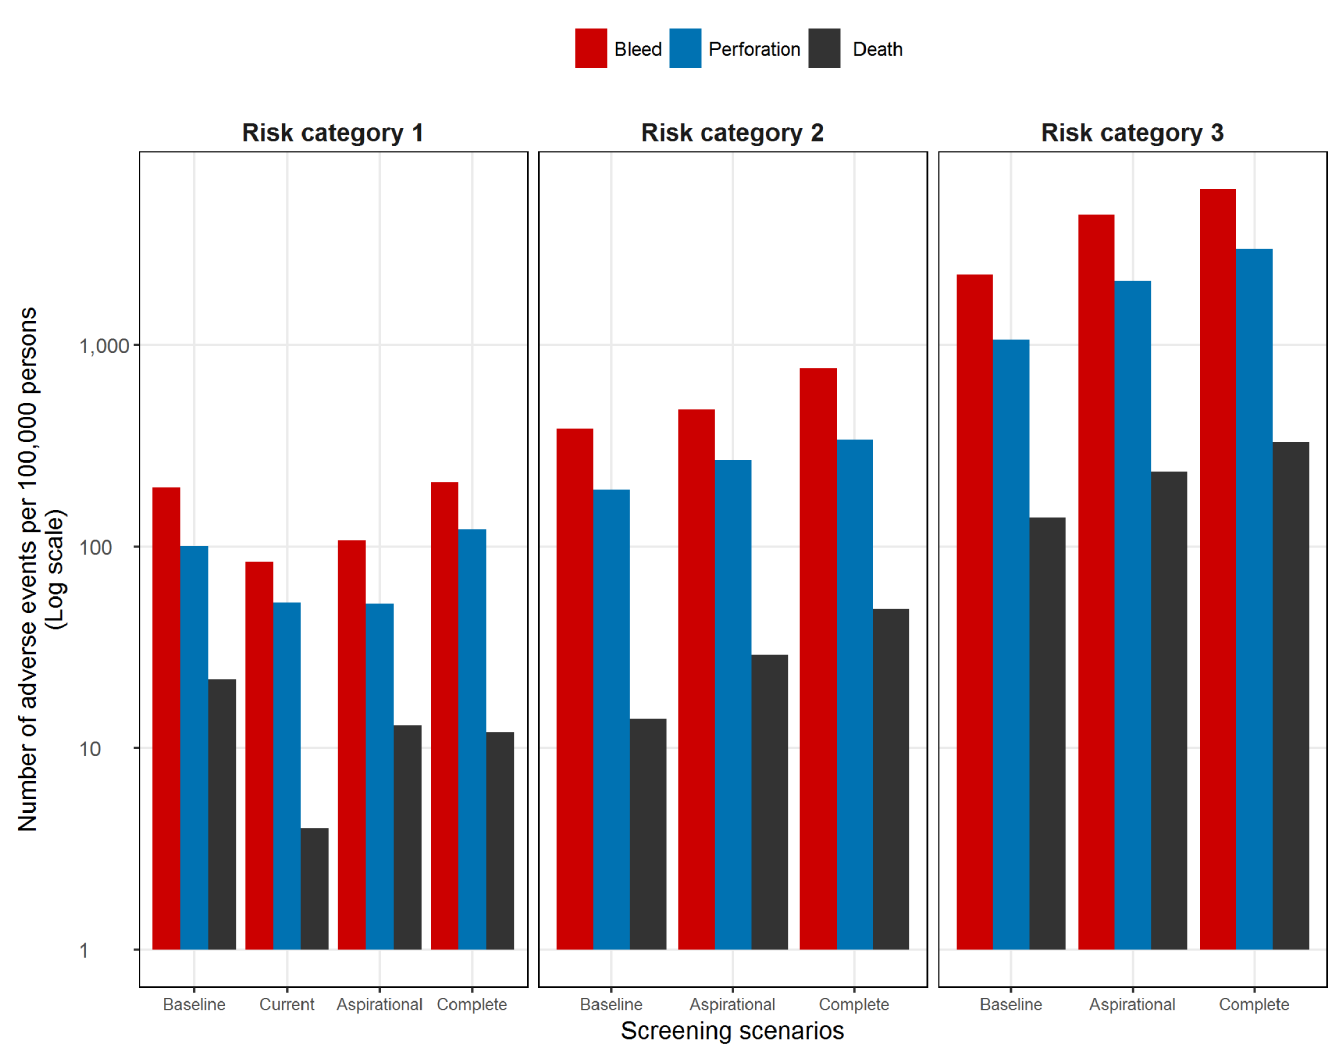
Fig 3. Number of adverse events associated with colonoscopy under different screening